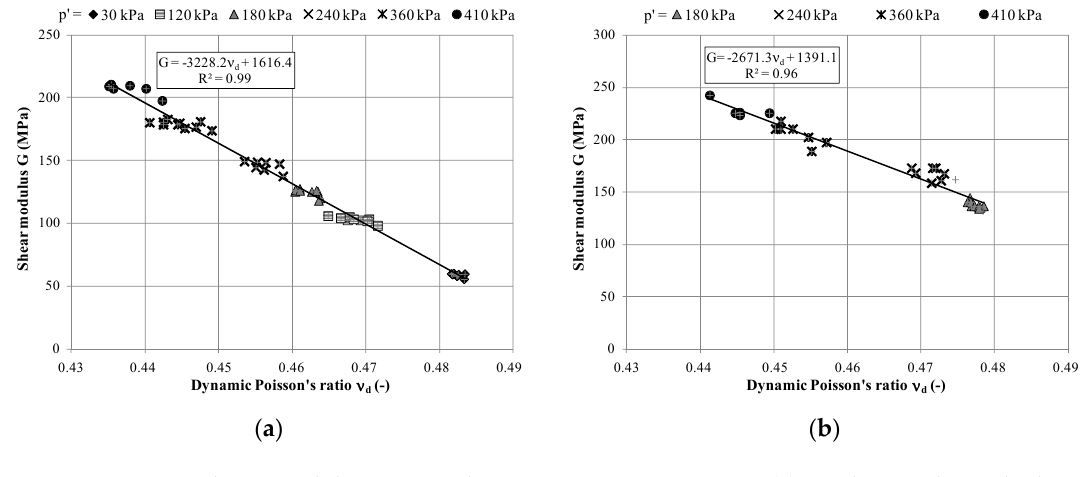
Figure 13. Shear modulus versus dynamic Poisson’s ratio. ( a ) Peak-to-peak method; ( b ) start-to-start method.